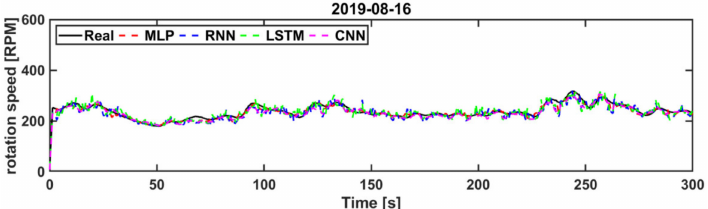
Figure 18. Comparison of the prediction performances of each algorithm for the conditions of Case 5 (training datasets: 26 April 2019, 20 July 2019; test dataset: 16 August 2019).